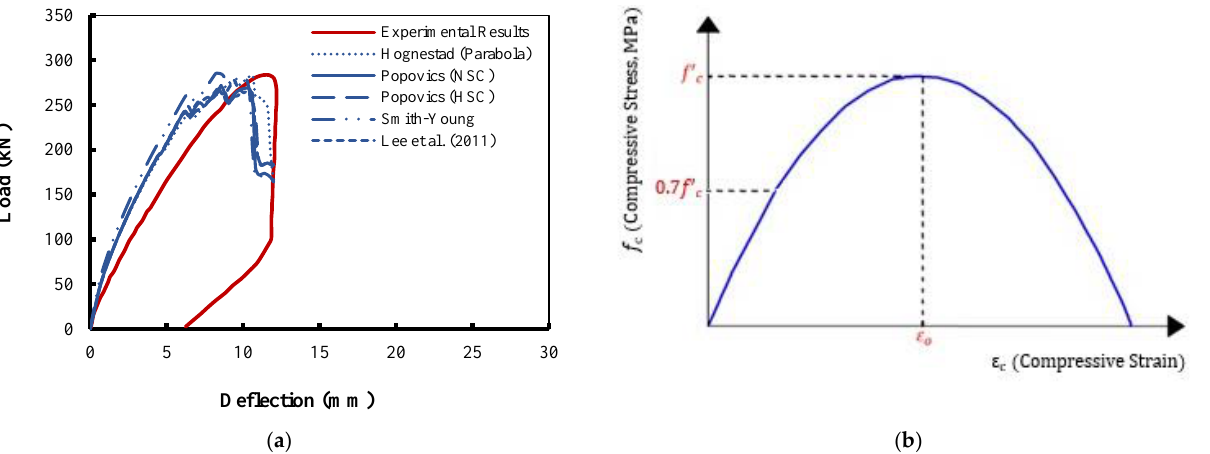
Figure 3. Concrete Compression Pre-Peak Response: ( a ) Comparison between Concrete Compression Pre-Peak Models Available in VecTor2; ( b ) Concrete Hognestad (Parabola) Pre-Peak Model [32,33].